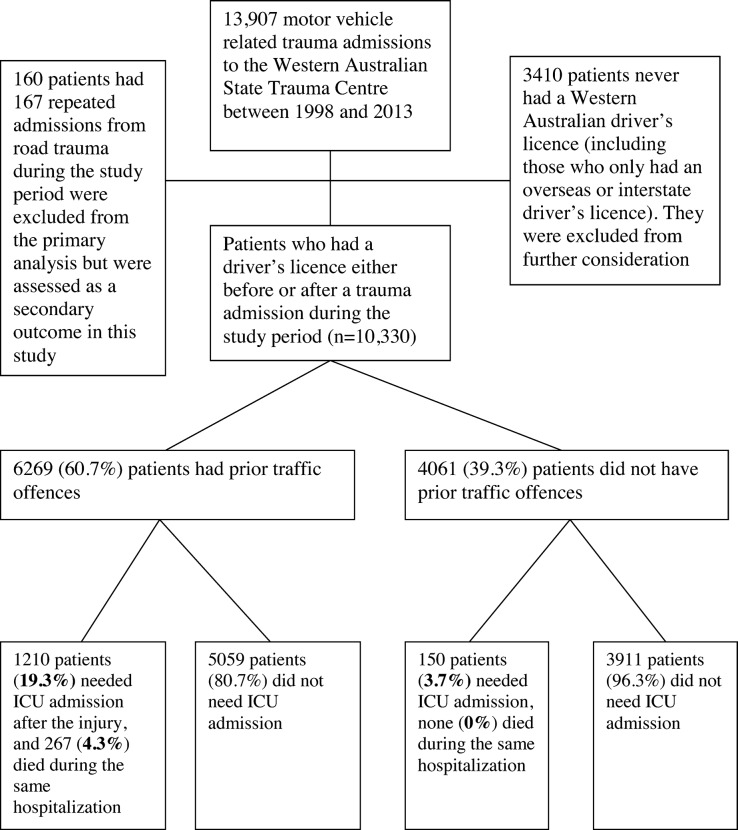
Flow chart showing inclusion and exclusion of patients for the study.ICU, intensive care unit.